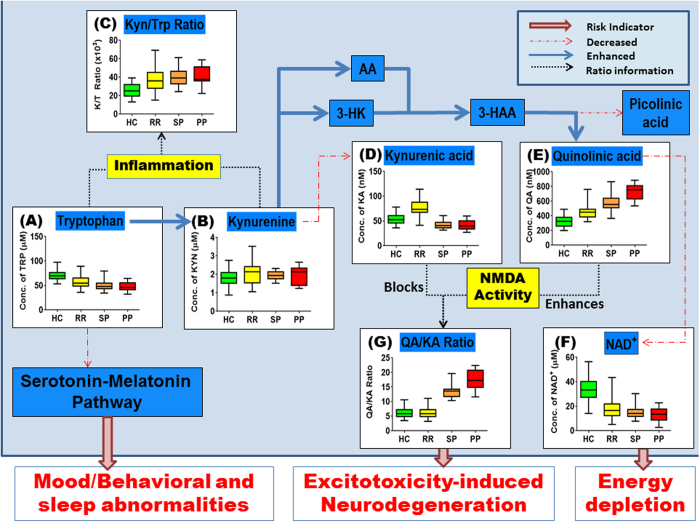
Overview of the kynurenine pathway with box plots of tryptophan (A), kynurenine (B), kynurenine/tryptophan (Kyn/Trp or K/T) ratio (C), kynurenic acid (D), quinolinic acid (E) NAD+ (F) and quinolinic acid/kynurenic acid (QA/KA) ratio (G) in healthy control (HC), relapsing-remitting MS (RR), secondary progressive MS (SP) and primary progressive MS (PP) cohorts. The diagram illustrate how inflammation can influence the pathway leading to enhance (blue arrows) in some downstream metabolites such as 3-Hydroxykynurenine (3-HK), Anthranilic acid (AA) and 3-Hydroxyanthranilic acid (3-HAA) but not others (red dotted arrows), i.e. kynurenic acid, picolinic acid and nicotinamide adenine dinucleotide (NAD+) based on patients with MS when compared to healthy control. The aberrant KP change in MS can potentially lead to mood/behavioural and sleep abnormalities, excitotoxicity-induced neurodegeneration and energy depletion related to cognitive fatigue in MS.